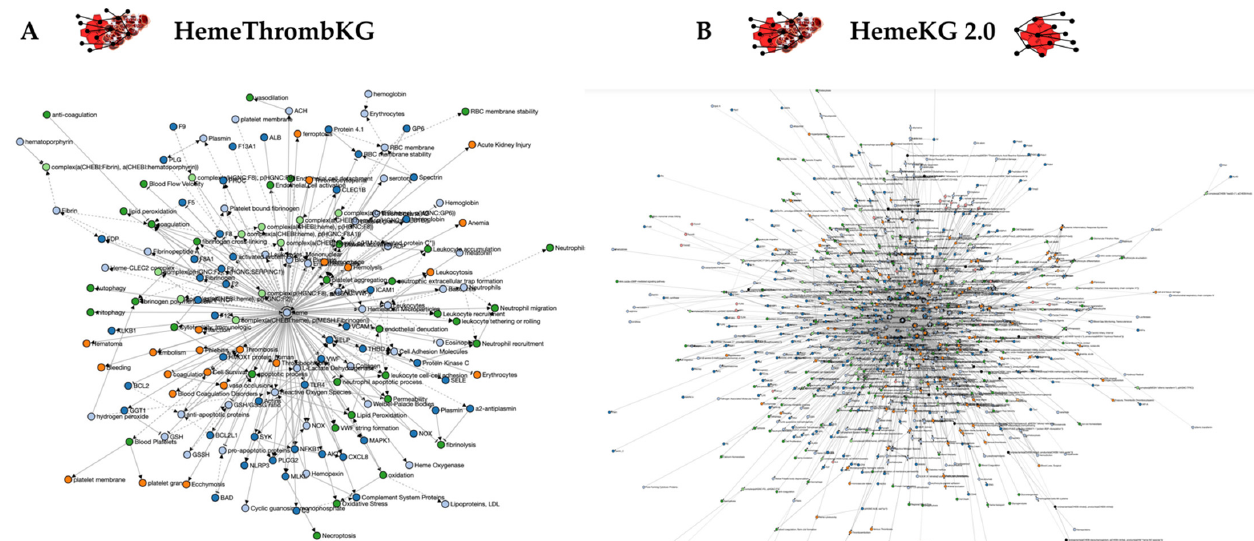
Figure 2. ( A ) The novel HemeThrombKG, consisting of 151 nodes and 426 edges, comprises the current knowledge of heme’s interferences in the blood coagulation system. ( B ) HemeKG 2.0 displays the extended knowledge graph of the earlier established HemeKG [17] by inclusion of the relations of HemeThrombKG. The network combines 868 nodes and 3430 edges. Nodes are colored according to their different functions in BEL (blue: protein, orange: pathology, green: biological process, red: miRNA, light green: complex, black: reaction, light orange: gene, light blue: abundance, pink: RNA).